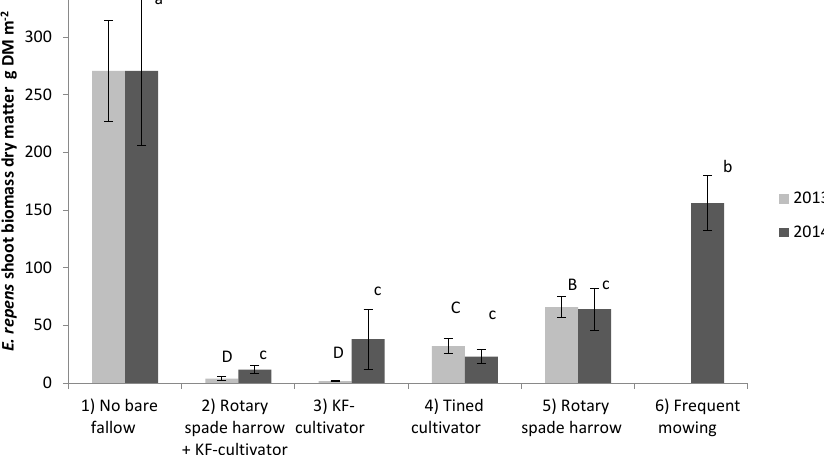
Fig. 3. Average dry matter of E. repens shoot biomass in autumn in experiment 2 (g DM m -2 ). The location of the experiment was changed between 2013 and 2014. Standard deviations of the treatments are marked with bars (n = 4). The treatments with different letters were significantly different at 95% confidence. Note: The significance can be compared only within of years, not between